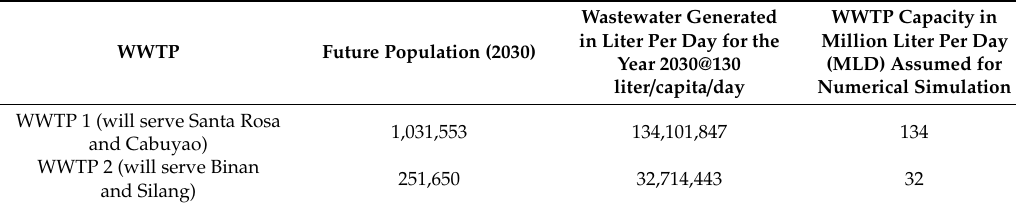
Table 3. Summary for WWTPs considered for the scenario